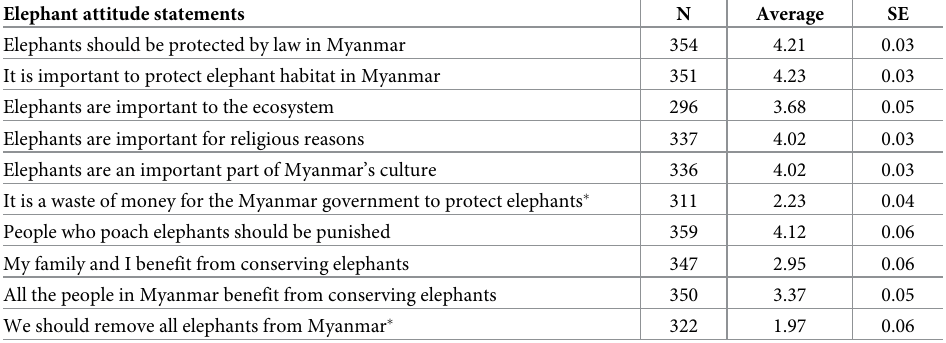
Table 6. Elephant conservation attitudes of 381 participants in the Bago-Yangon and Ayeyarwady regions of Myanmar (May 2017-December 2018).